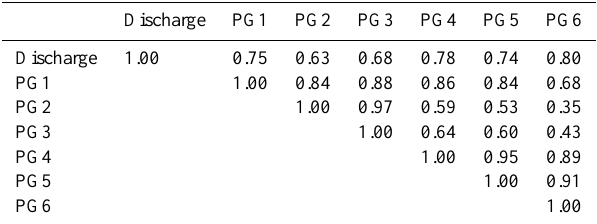
Table 1. Coefficient of correlation between discharge and water table depth in the six wells (PG1 to PG6) during the study